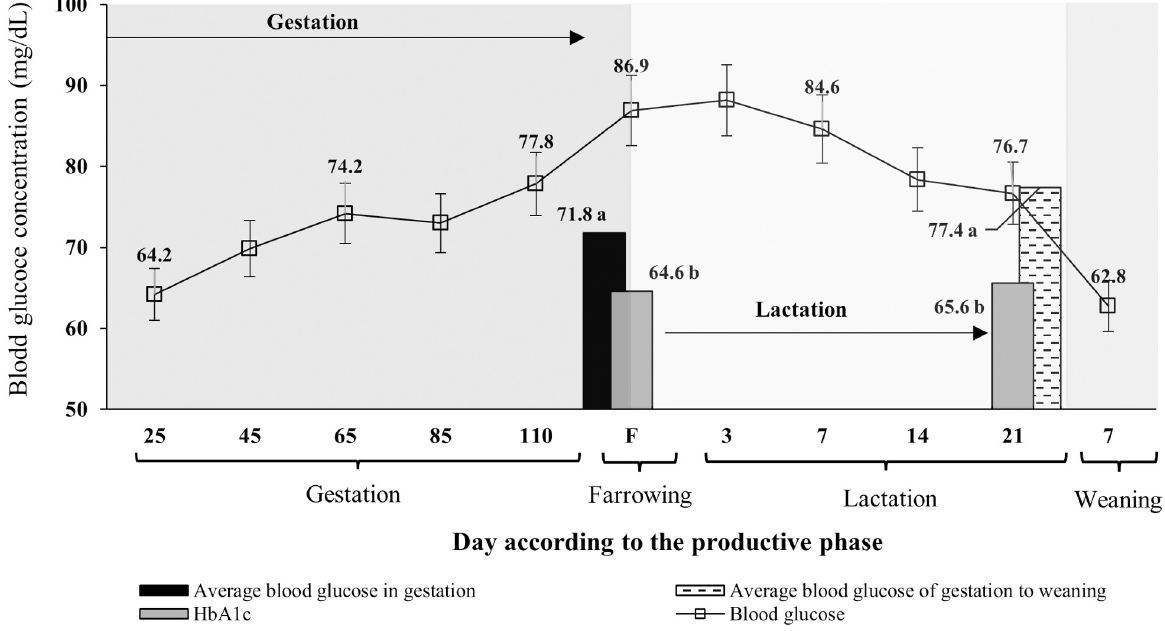
Fig 1. Dynamics of preprandial blood glucose of sows during the gestation to weaning phases and HbA1c on the farrowing and weaning day, regardless of cactus intake during lactation. Each point or bar represents the mean ± standard error of mean (SEM; n = 36 sows).